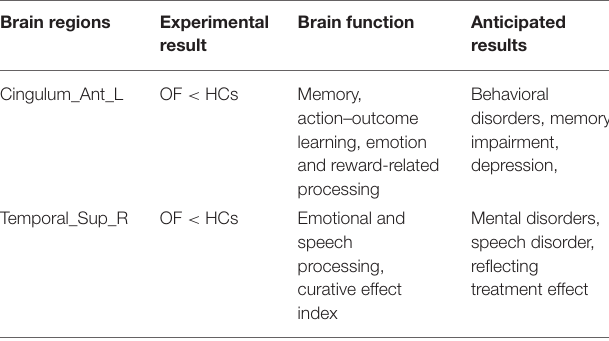
TABLE 4 | Brain areas of altered fALFF values and anticipated results. Brain